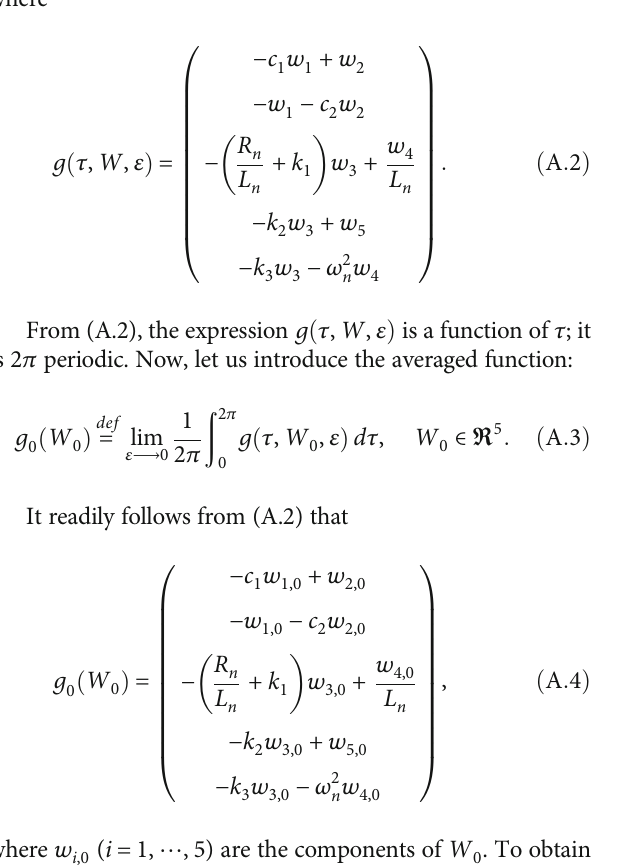
at the terminals of sensitive load after L